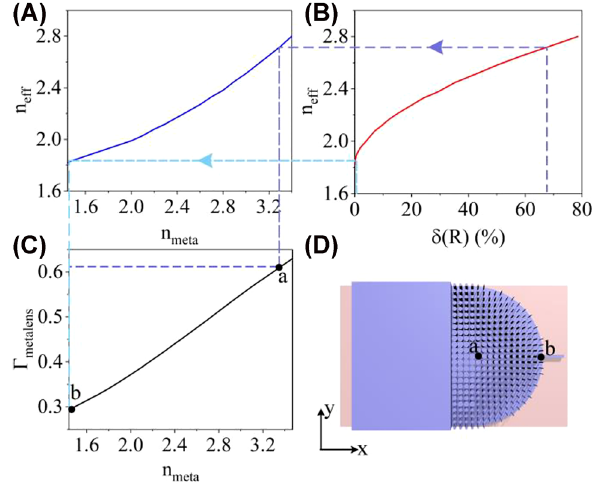
Figure 2: Look-up table about the ability of the GRIN metalens to confine the mode field. (A) Calculated effective refractive index ( n ) eff ). (B) Relationship with varied equivalent material index ( n meta ) and filling ratio ( 𝛿 ( R )). (C) between effective refractive index ( n eff Calculated fraction 𝛤 of the optical power confined in the 160 metalens nm-height GRIN metalens with varied equivalent material index ). (D) Location of the maximum (point a) and minimum (point b) ( n meta refractive